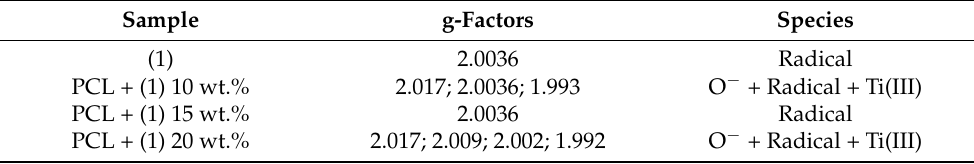
Figure 5. EPR spectra of PCL with 10 ( A ), 15 ( B ) and 20% ( C ) of ( 1 ) samples. Some experimental conditions: cut foil, room temperature, microwave frequency: 9.32711 ( A ), 9.32518 ( B ), 9.32473 ( C ) GHz; microwave power: 40 mW; modulation amplitude: 1 mT; sweep: 20 mT; sweep time: 4 min.; time constant: 0.1 s; receiver gain: 4 × 10 5 ( A , B ), 2 × 10 5 ( C ). Measurement time: fresh sample ( A ), after a month ( B ) and fresh sample ( C ). Table 2. EPR data for pure TOC ( 1 ) and PCL with 10 (a), 15 (b) and 20% (c) TOC.